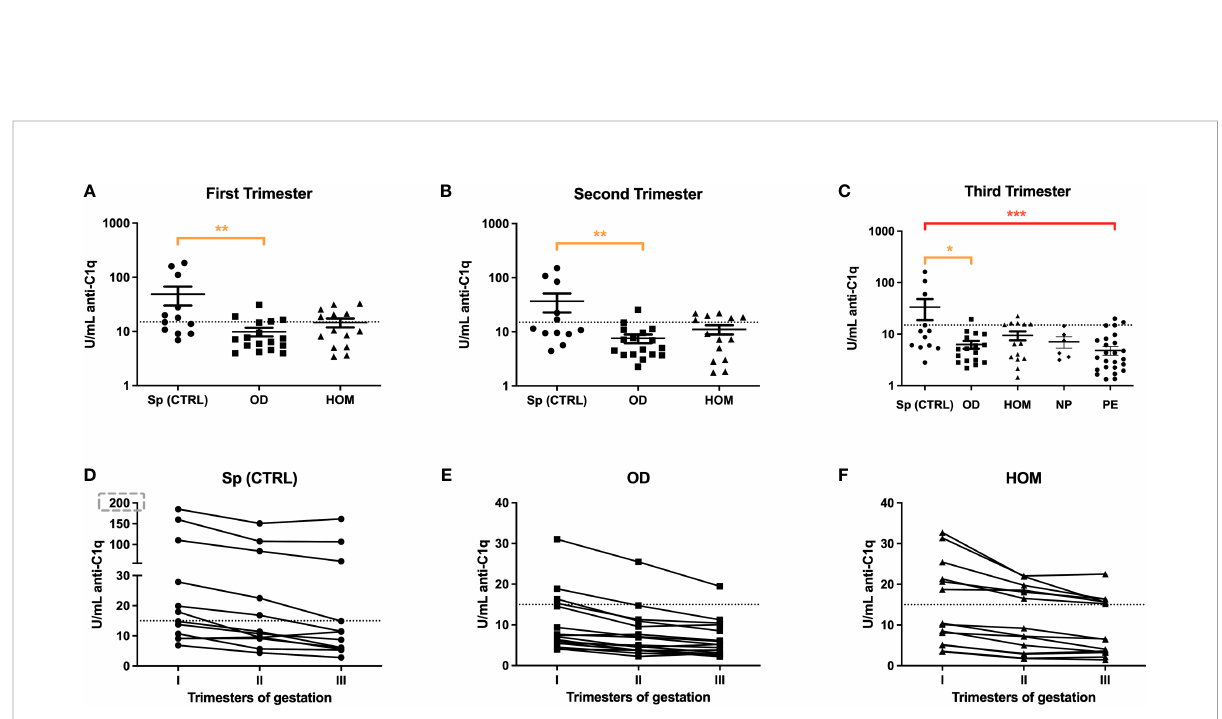
FIGURE 6 Anti-C1q autoantibodies in Sp CTRL, OD and HOM pregnancies. Serum levels of anti-C1q were measured in the fi rst (A) , second (B) and third (C) trimester of pregnancy. The levels were signi fi cantly lower in OD and HOM pregnancies compared to Sp CTRL during all trimesters (*p<0.05; **p<0.01; ***p<0.001; T-test). The before-after plots (D, E, F) suggest a decrease in anti-C1q titres with the progression of gestational